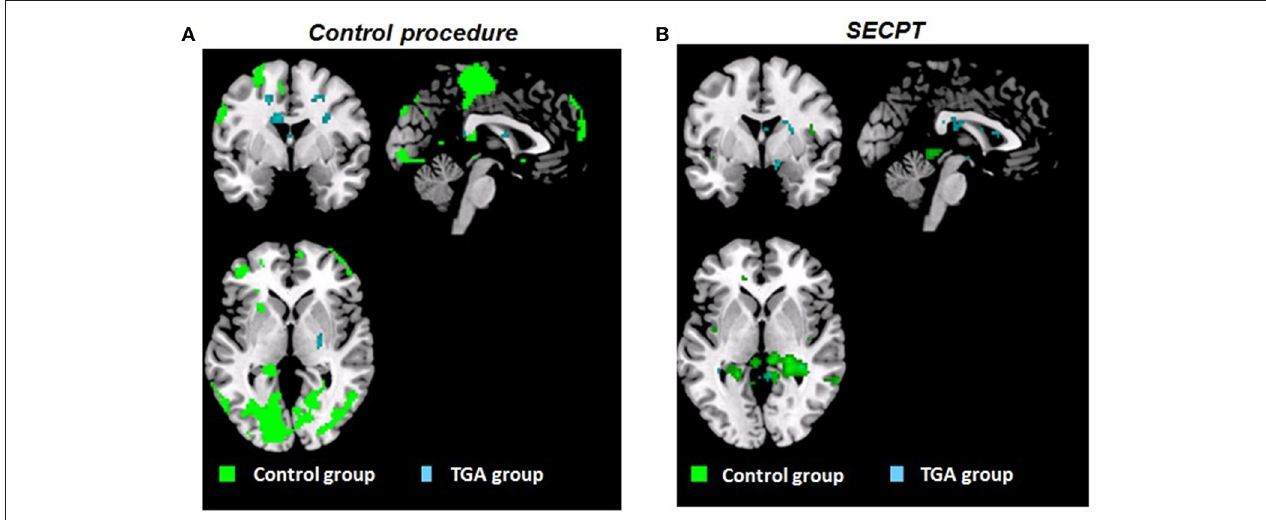
FIGURE 4 | Whole brain activation patterns ( p FWE < 0.05). Contrast CON + > CON − during the acquisition phase of the contextual fear conditioning paradigm (A) following the control procedure, (B) following the SECPT. Activation in control group indicated in green, TGA group in blue. CON + , conditioned stimulus paired with the unconditioned stimulus; CON − , conditioned stimulus never paired with the unconditioned stimulus; SECPT, Socially Evaluated Cold Pressor Test; TGA, transient global amnesia.